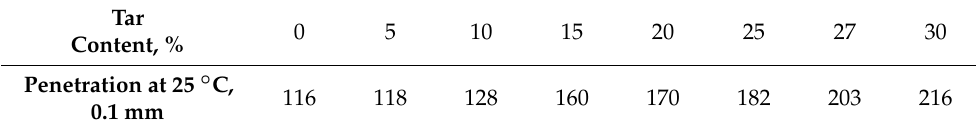
Table 5. Bitumen penetration at different tar contents.